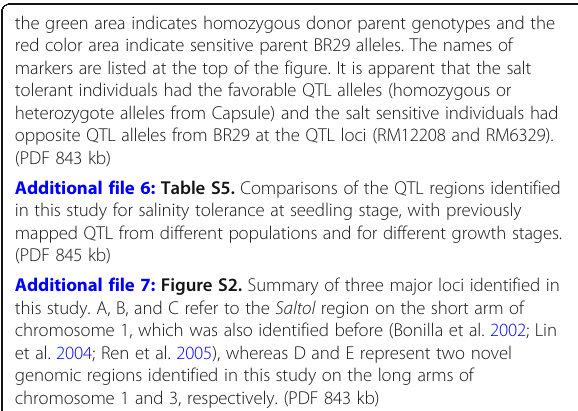
markers are listed at the top of the figure. It is apparent that the salt tolerant individuals had the favorable QTL alleles (homozygous or heterozygote alleles from Capsule) and the salt sensitive individuals had opposite QTL alleles from BR29 at the QTL loci (RM12208 and RM6329). Additional file 6: Table S5. Comparisons of the QTL regions identified in this study for salinity tolerance at seedling stage, with previously mapped QTL from different populations and for different growth stages. (PDF 845 kb) Additional file 7: Figure S2. Summary of three major loci identified in this study. A, B, and C refer to the Saltol region on the short arm of chromosome 1, which was also identified before (Bonilla et al. 2002; Lin et al. 2004; Ren et al. 2005), whereas D and E represent two novel genomic regions identified in this study on the long arms of chromosome 1 and 3, respectively. (PDF 843 kb) Abbreviations CIM: Composite interval mapping; GGT: Graphical genotyping; IM: Interval mapping; LOD: Logarithms of odds; PVE: Phenotypic variation